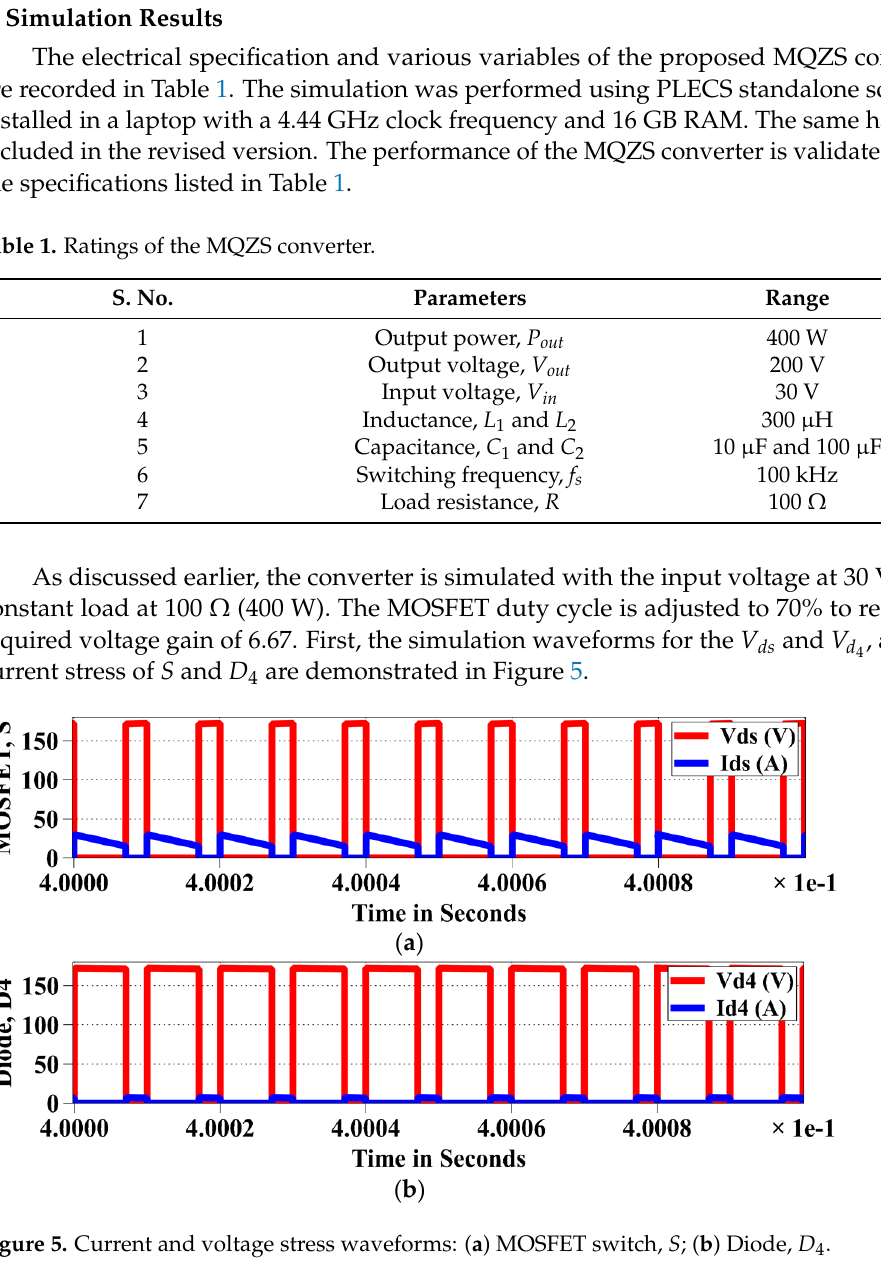
Figure 6. Inductor current waveforms of the converter. The current and voltage stresses of the diodes, D 1 –D 3 and D 5 are demonstrated in Figure 7. From Figure 7a,b, the diode voltage stress, V d 1 and V d 3 are equivalent to 70 V. The diode voltages, V d 2 , are equal to 30 V, as realized in Figure 7c. The voltage across the diode, V d 5 , is equal to 100 V, as realized in Figure 7d. All the voltages are equal to the theoretical values as per Equations (5), (9) and (10).